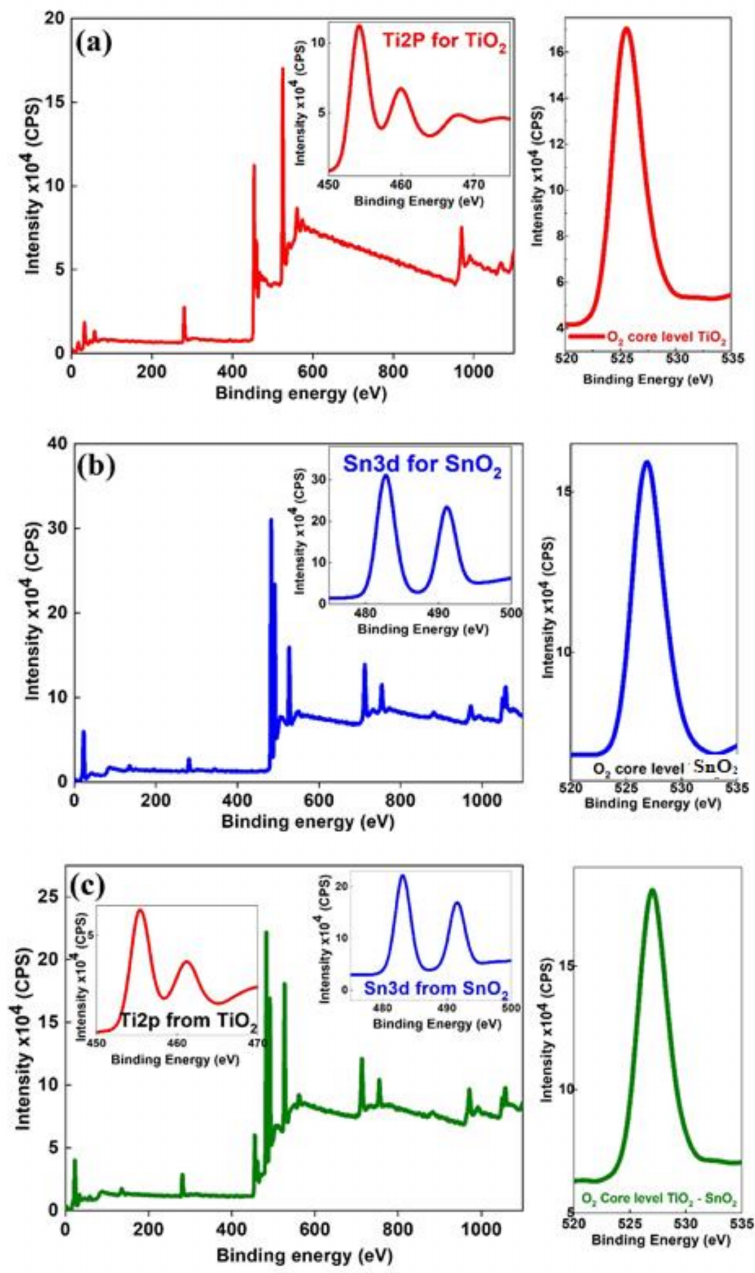
Figure 4. ( a ) XPS survey spectra for TiO 2 , Ti2p bands, and O 2 core levels of TiO 2 ; ( b ) XPS survey spectra of SnO 2 , Sn 3d bands, and O 2 core levels of SnO 2 ; ( c ) XPS survey spectra of composite TiO 2 -SnO 2 , Ti2p, and Sn3d as composite TiO 2 -SnO 2 fibers and O 2 core levels composite TiO 2 -SnO 2